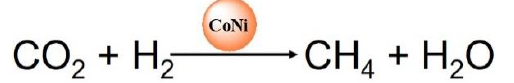
Scheme 1. The reaction of methanation with CO 2 and H 2